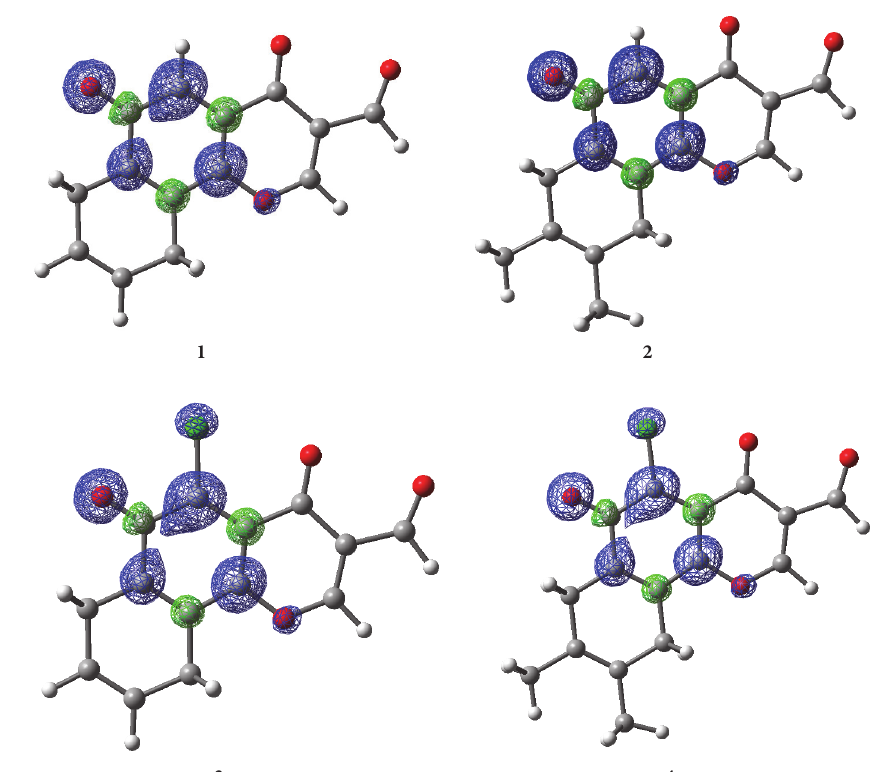
Figure 2: Spin density isosurface (isovalue = 0.004) for four radical molecules (water PCM solvated). Blue indicates positive and green indicates negative spin density values.